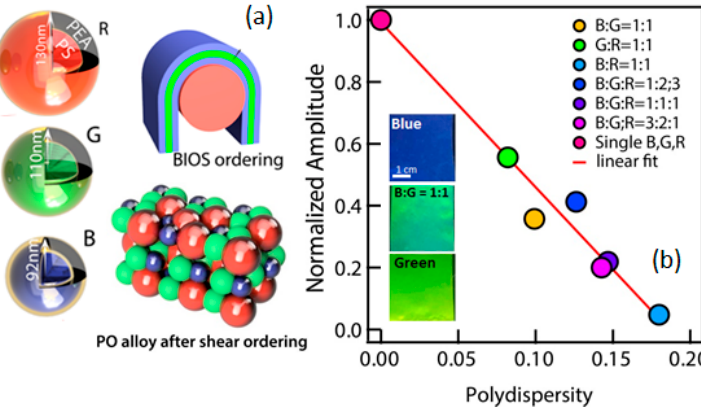
Figure 5. ( a ) B, G, and R represent core–shells spheres of different sizes that make blue, green, and red single-component POs, respectively, and which may be BIOS processed to produce opaline alloys; ( b ) Normalized Bragg peak amplitude versus sample polydispersity; the colored points denote the various binary and ternary alloys, as per the figure legend. The inset shows photographs of BIOS-processed POs with different blue (B) and green (G) components, including a 1:1 alloy with intense structural color. (Adapted from Ref. [35] with permission of Wiley).